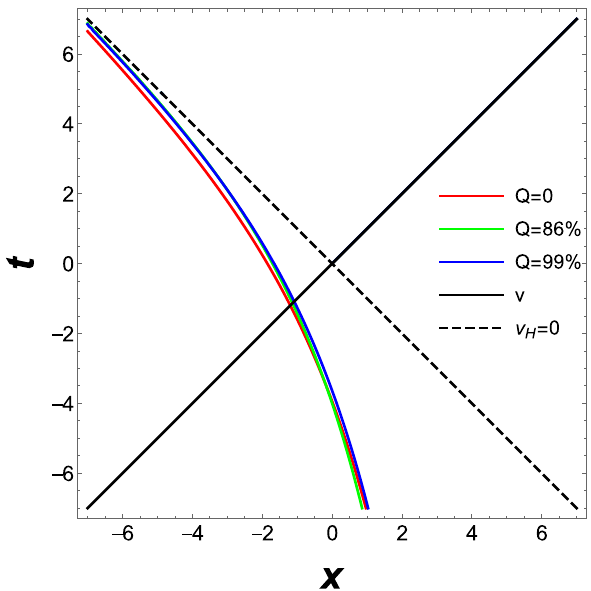
Fig. 1 Trajectories Eq. (11), in a spacetime plot. The horizon has been √ set to v H = 0, the charge is Q = 0, Q = 3 / 2 = 86% and Q = 99%, for M = 1. The mirrors starts asymptotically static, but have infinite proper acceleration in the far future. As can be seen, effectively, charge does not significantly alter the qualitative behavior of the